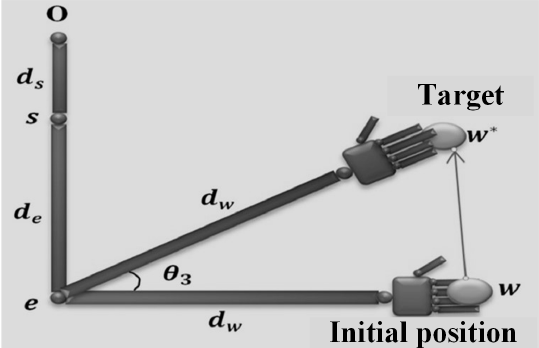
Figure 16. Geometrical solution of joint θ 3